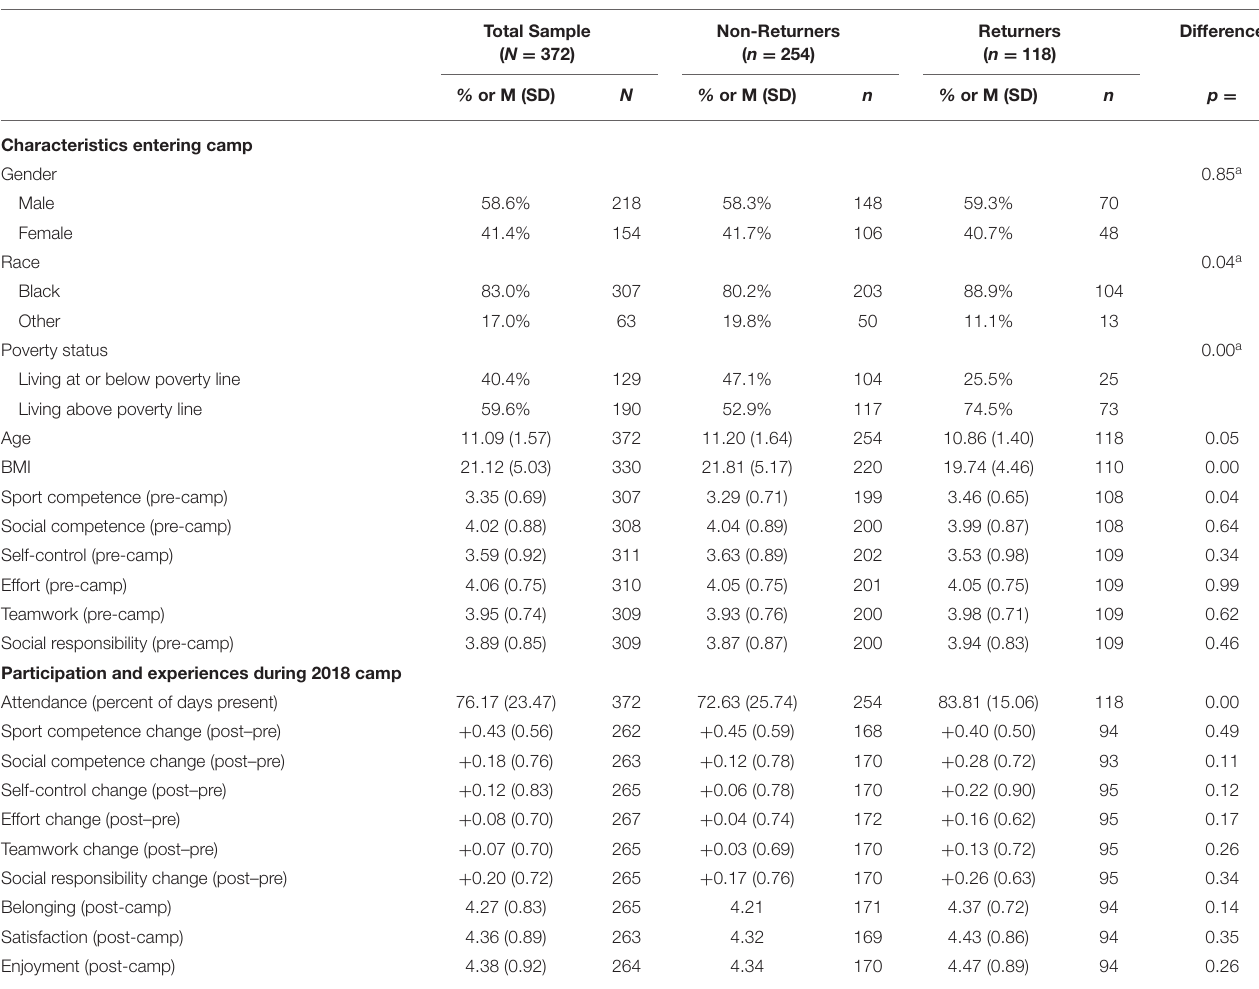
TABLE 1 | Profile of campers overall and by returning